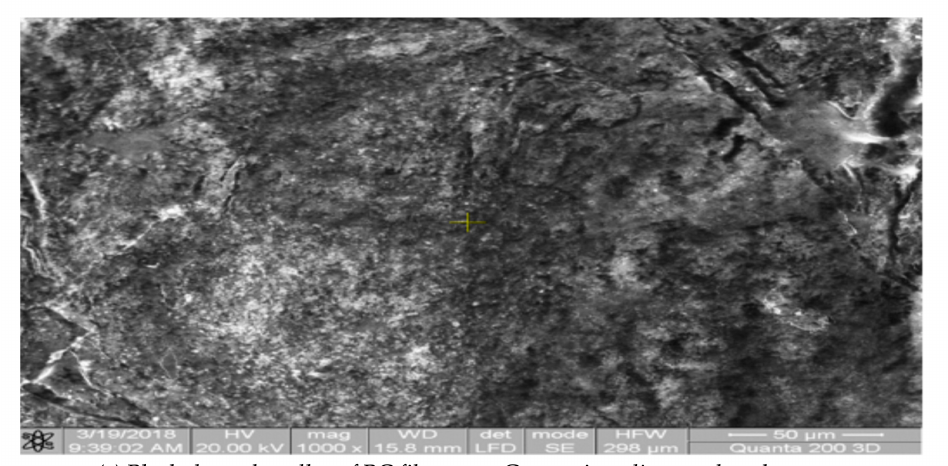
Figure 5. ( a ) A SEM microphotography of the BC scaffold. ( b ) SEM microphotography of the BC- β -keratose scaffold. ( c ) SEM microphotography of the BC- γ -keratose